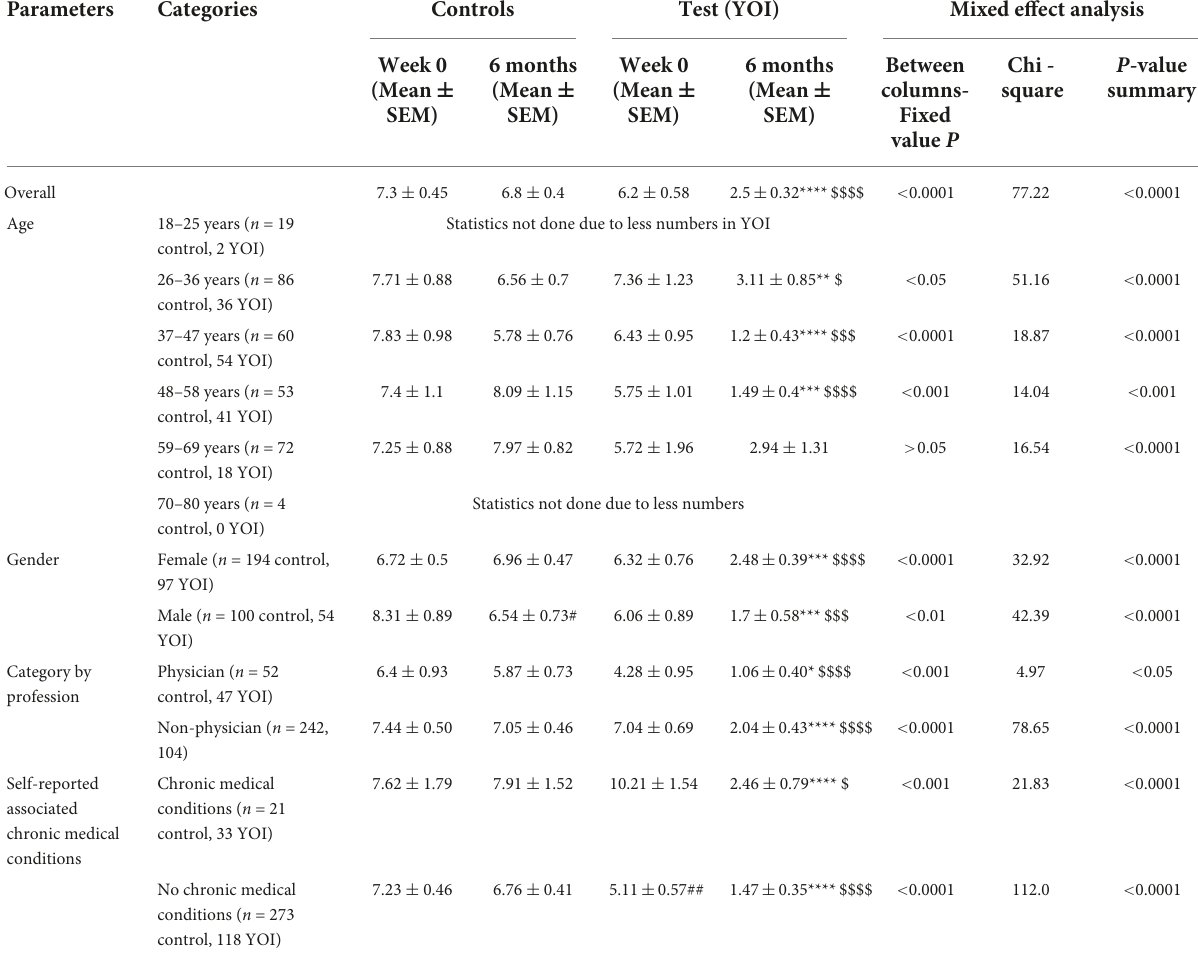
TABLE 3 Overall mean total ISI score and mean total ISI scores for demographic parameters in control and YOI